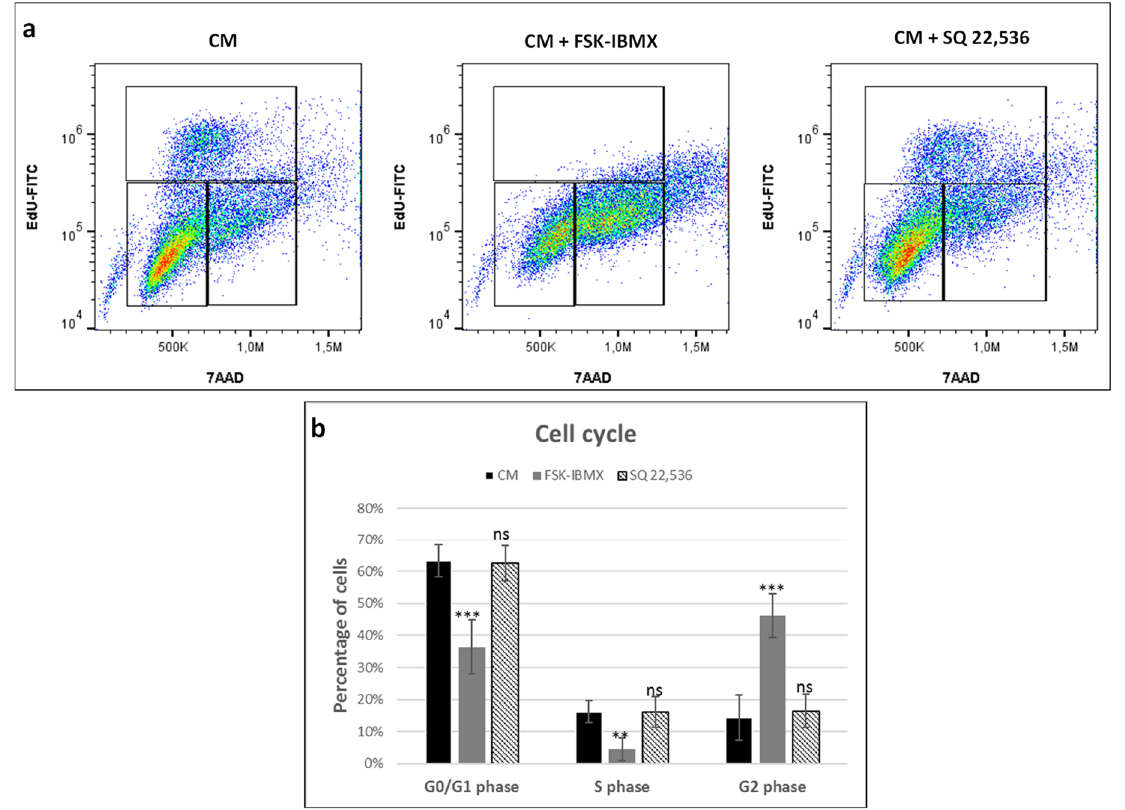
Figure 3. Effect of cAMP pathway regulation on cell cycle. Cells cultured in CM and treated with adenylate cyclase activator forskolin (FSK, 10 nM) and phosphodiesterase inhibitor 3-isobutyl-1- methylxanthine (IBMX, 500 nM), or with adenylate cyclase inhibitor SQ 22,536 (100 nM) for 24 h and